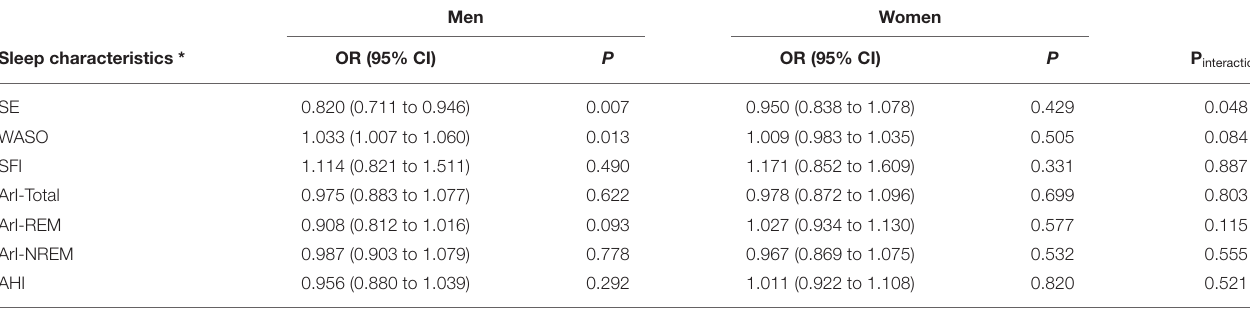
TABLE 3 | Multivariate logistic regression analysis for sleep characteristics associated with depression stratified by